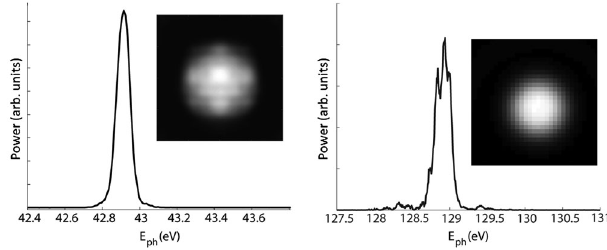
FIG. 4. Spectral power and transverse intensity distribution (inset) at the end of the FEL1 (left) and FEL2 undulator line. G enesis 1.3 simulation. Electron beamlet parameters as in Table